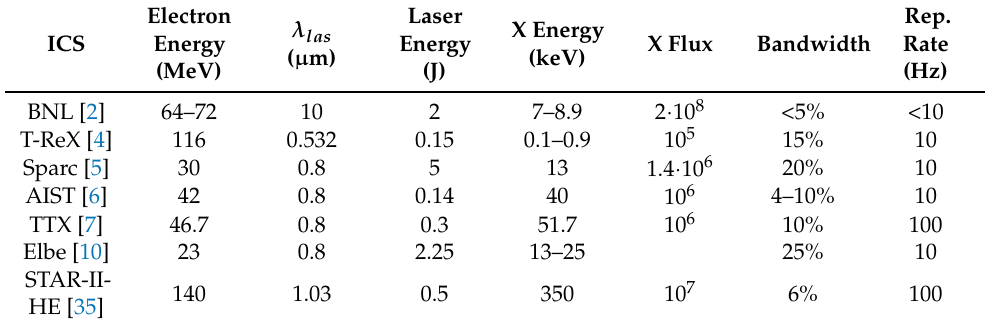
Figure 1. STAR machine as an example of Paradigm (i). Overall length about 12 m. 1: S-band RF Gun; 2: S-band Accelerating section; 3a,b: C-band Accelerating sections, 4a,b: low energy and high energy beam transport lines; 5a,b: low energy and high energy interaction chambers; 6: S-band RF power station; 7a,b: C-band RF power stations; 8: photo-cathode laser transport line; 9: interaction laser transport line. Courtesy of L. Pellegrino. Table 1. Warm linacs versus high-energy laser. The number of photons is per shot. All data are measured apart the case of STAR, whose data are evaluated